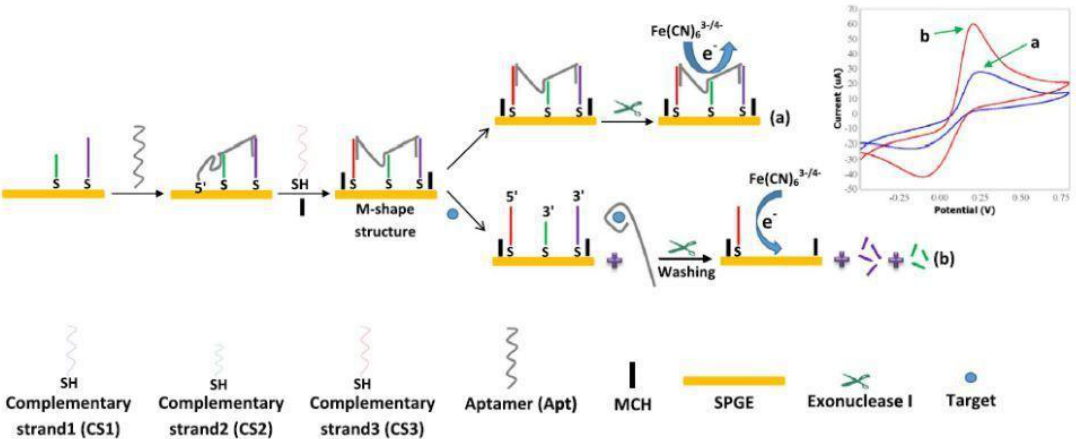
Figure 4. Schematic illustration of tetracycline detection based on electrochemical method. In the absence of tetracycline, the M-shape structure of Apt-CSs complex remains intact and redox probe could not have access to the surface of electrode, leading to a weak electrochemical signal ( a ). In the presence of tetracycline, Apt binds to tetracycline and leaves the CSs. Exo I degrades CS1 and CS2, resulting in the free access of redox mediator to the surface of electrode and a strong electrochemical signal ( b ). Reprinted from [42] with permission from Elsevier.